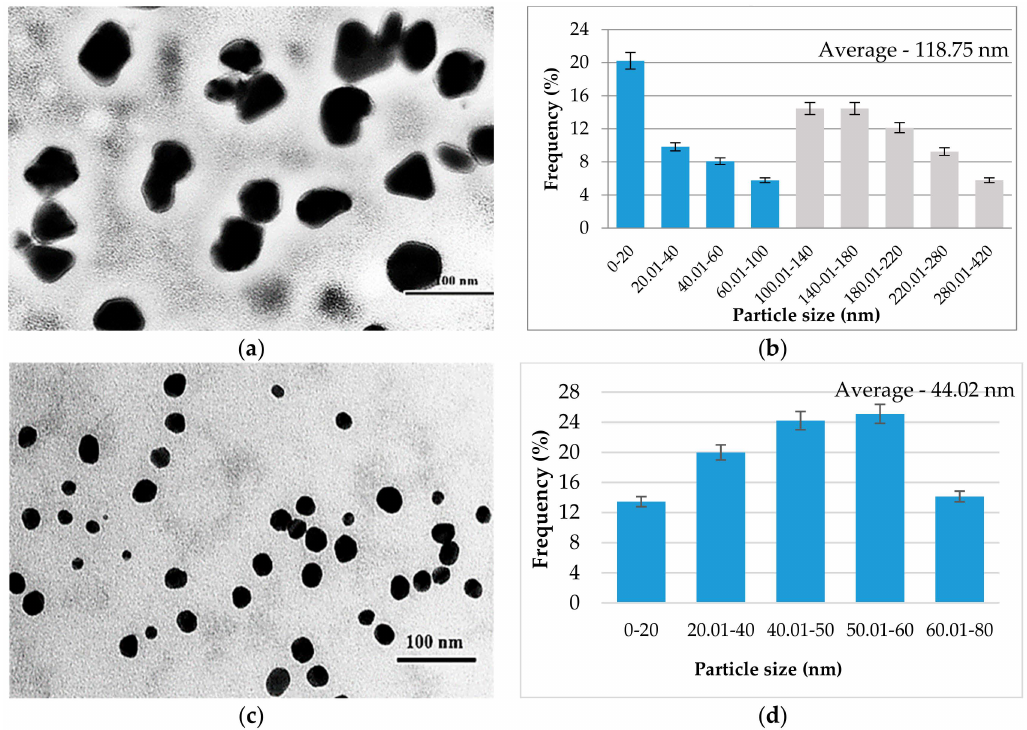
Figure 5. Graphical representation of AgNPs synthesized in the presence of the extract obtained from the beech bark and AgC 2 H 3 O 2 : ( a ) TS3— TEM photomicrograph; ( b ) histogram of the distribution of AgNP size distribution in TS3; ( c ) TS4—TEM image; ( d ) histogram of the distribution of AgNP size distribution in TS4. (TS3—beech bark extract, pH = 4, AgC 2 H 3 O 2 ; TS4—beech bark extract, pH = 9, AgC 2 H 3 O 2